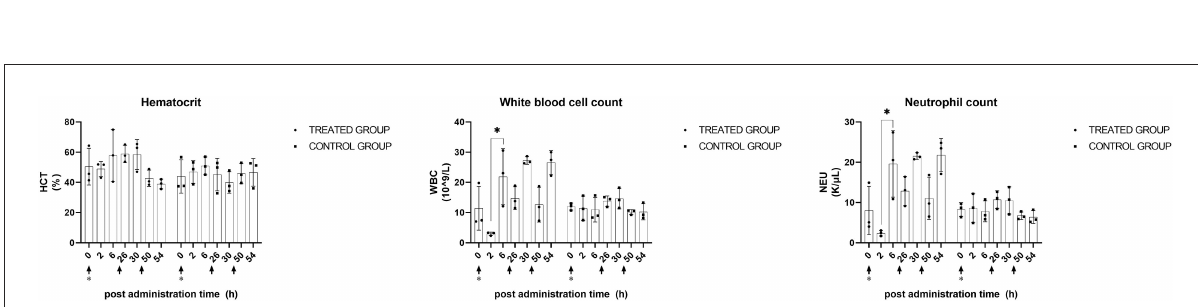
FIGURE5 CBC profiles after KMRC011 or normal saline administration. KMRC011 was administered (solid arrows) at 0, 24, and 48h after irradiation (asterisk). WBC and NEU showed significant changes after the first administration while no observed statistical significance after the second and